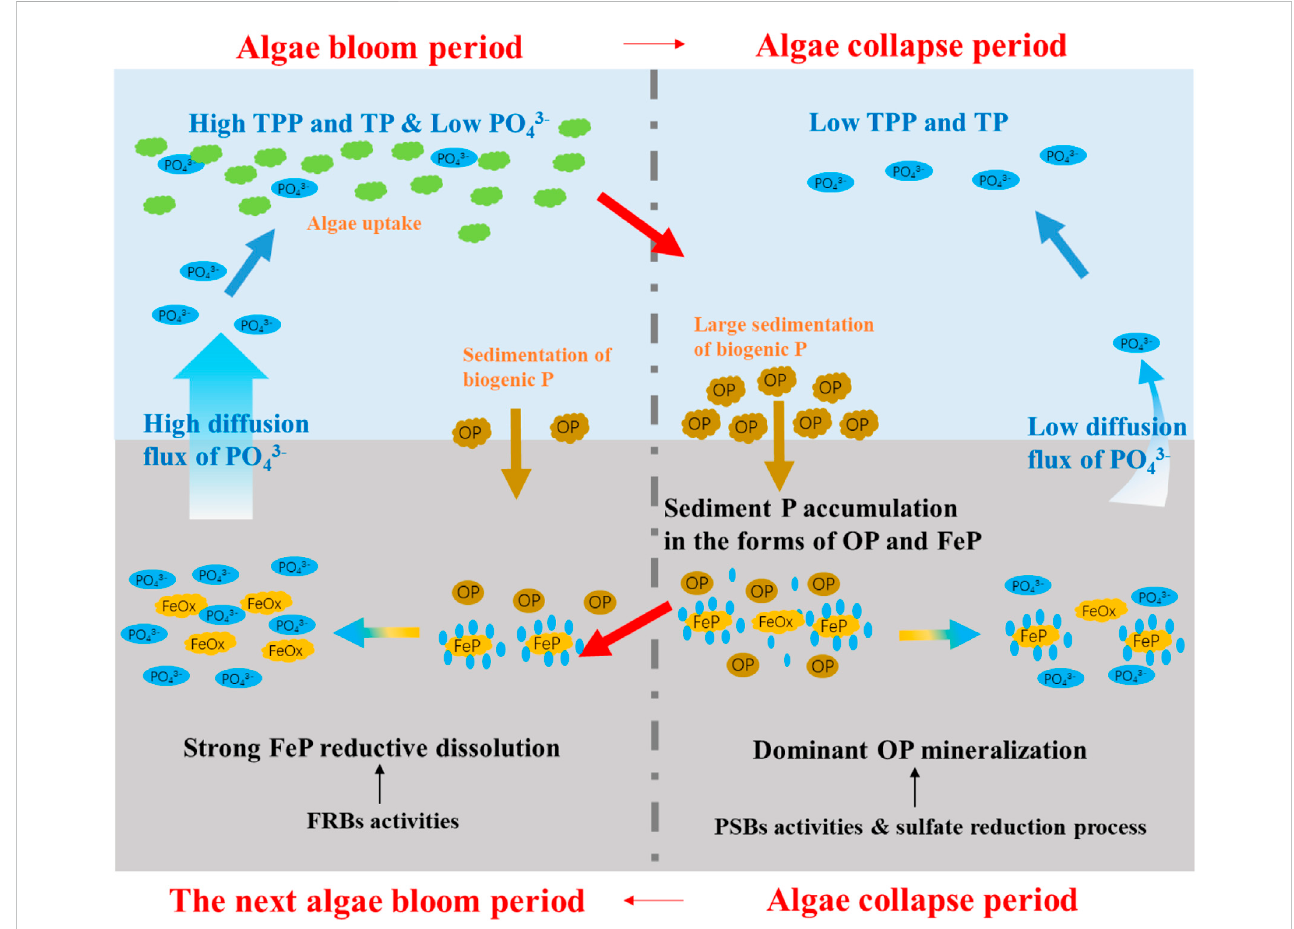
FIGURE 7 The periodic variations of internal P cycles during the algae bloom and algae collapse periods. FRBs represent typical kinds of iron-reducing bacteria, PSBs represent organic P-solubilizing